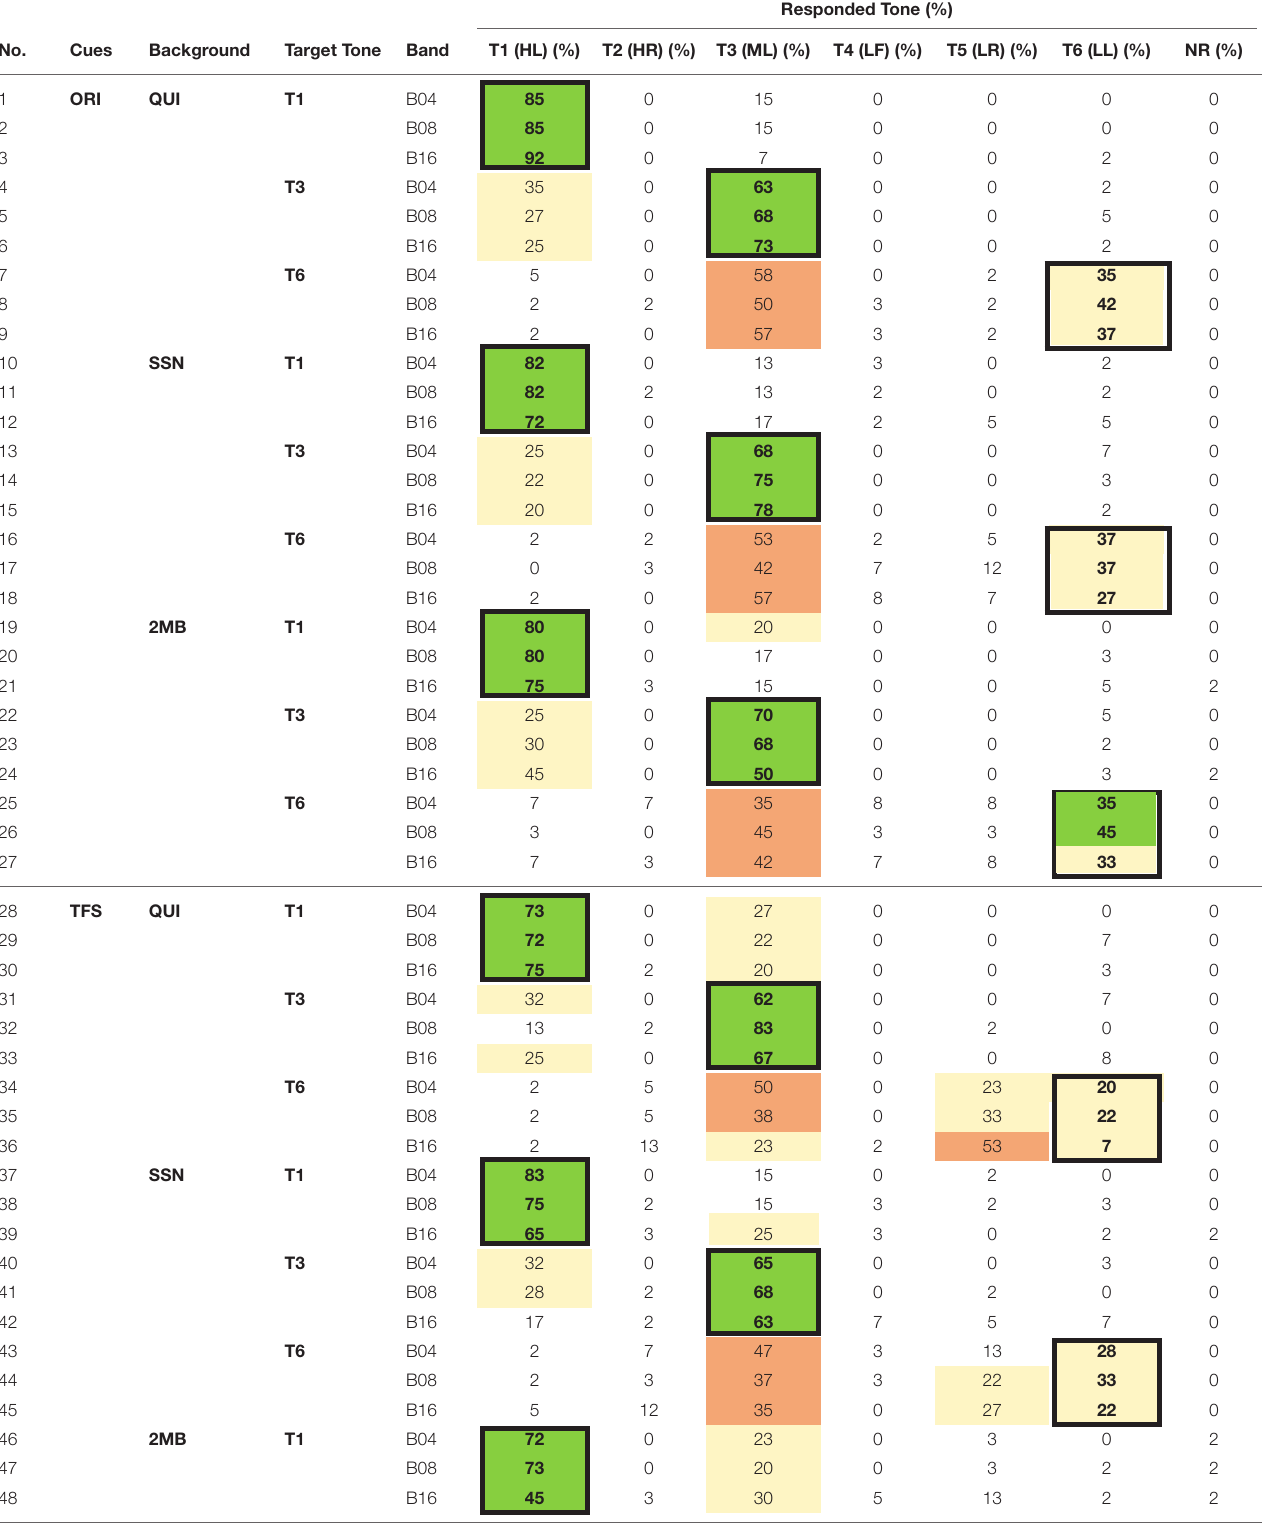
TABLE 13 | Confusion matrix of the three level tones–T1 (HL), T3 (ML), T6